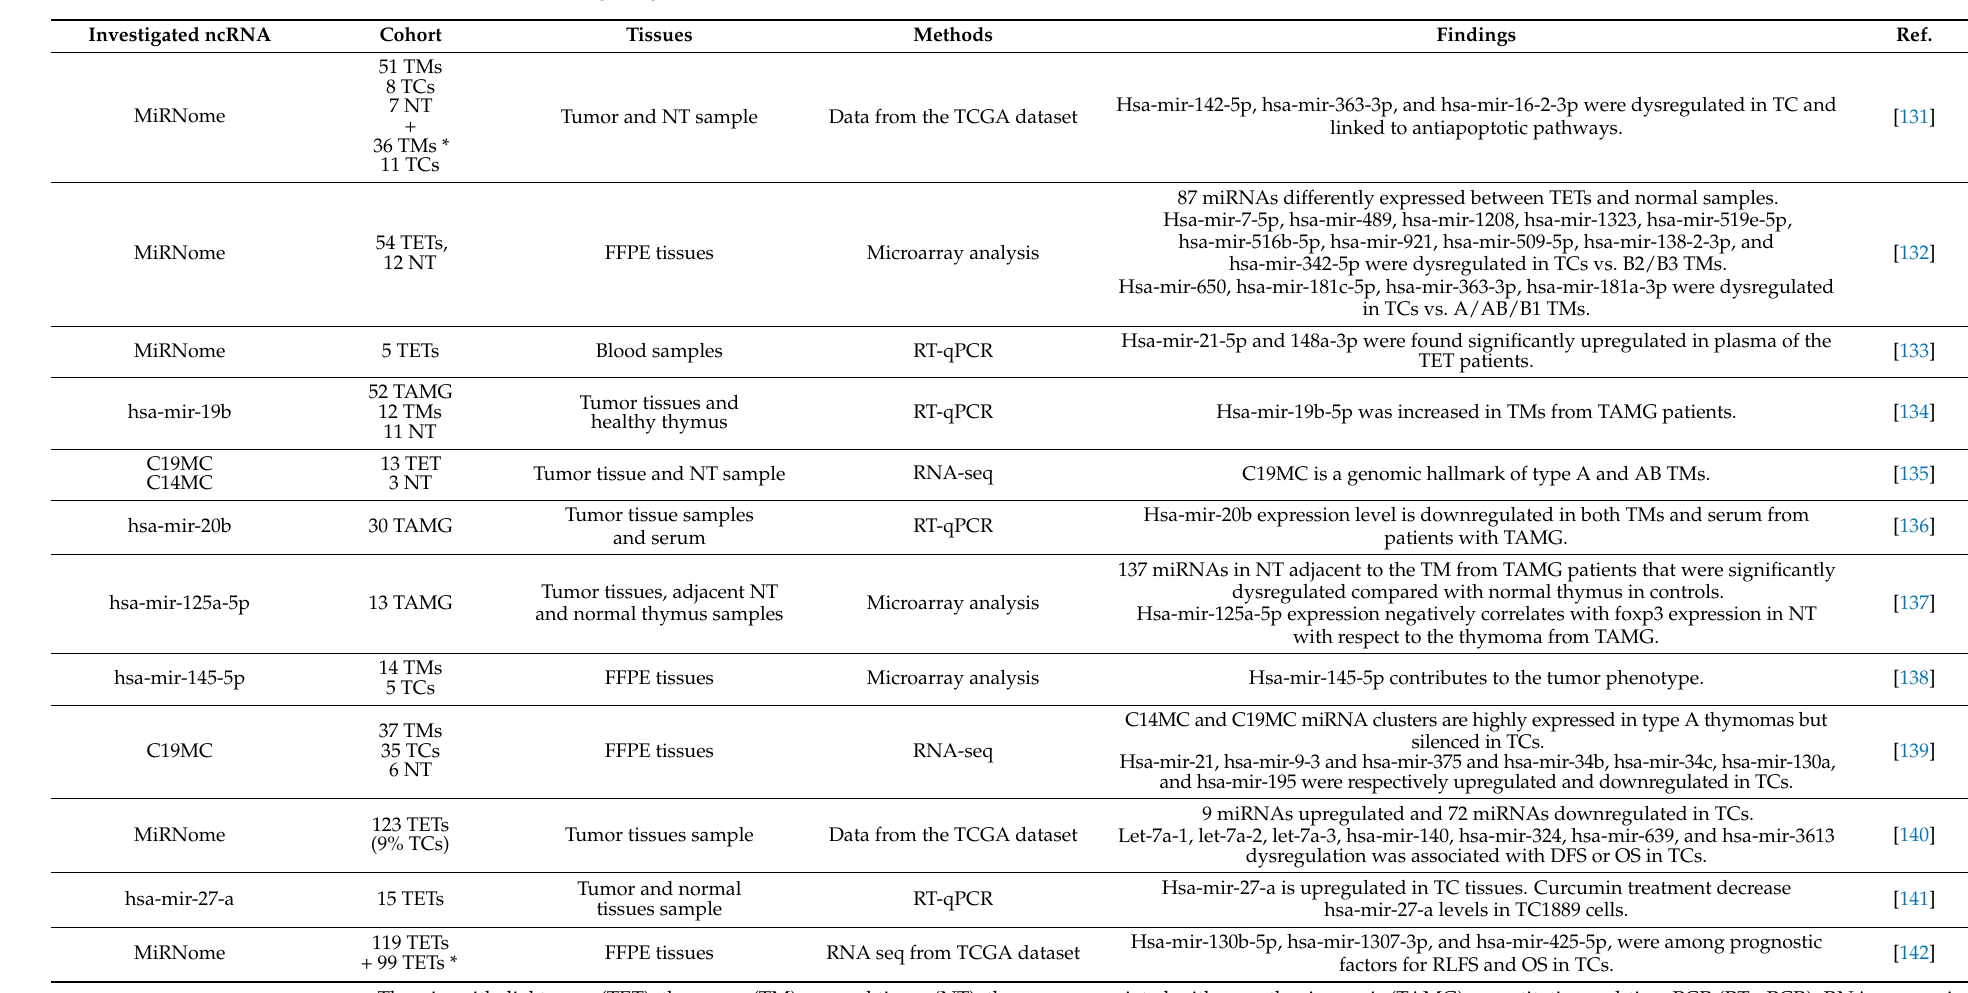
Table 2. Works investigating microRNAs in